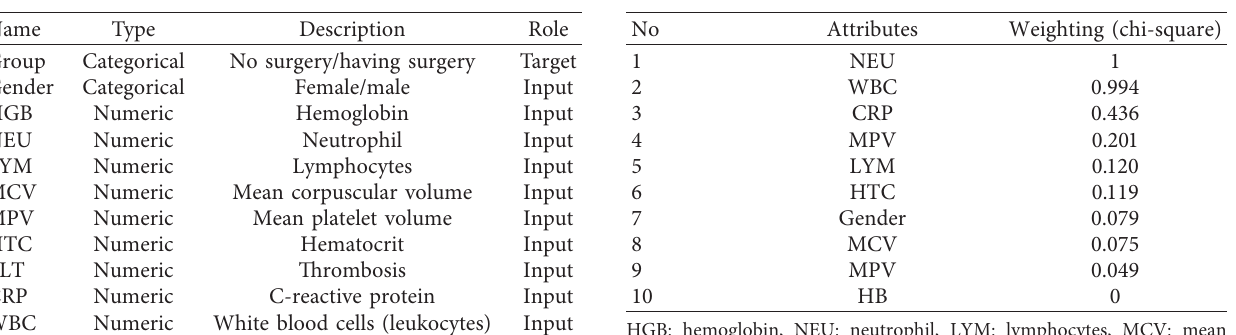
Table 1: Dataset description.